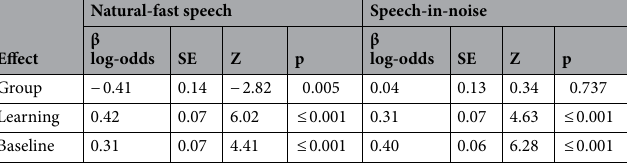
Table 3. Prediction models for speech recognition as a function of perceptual